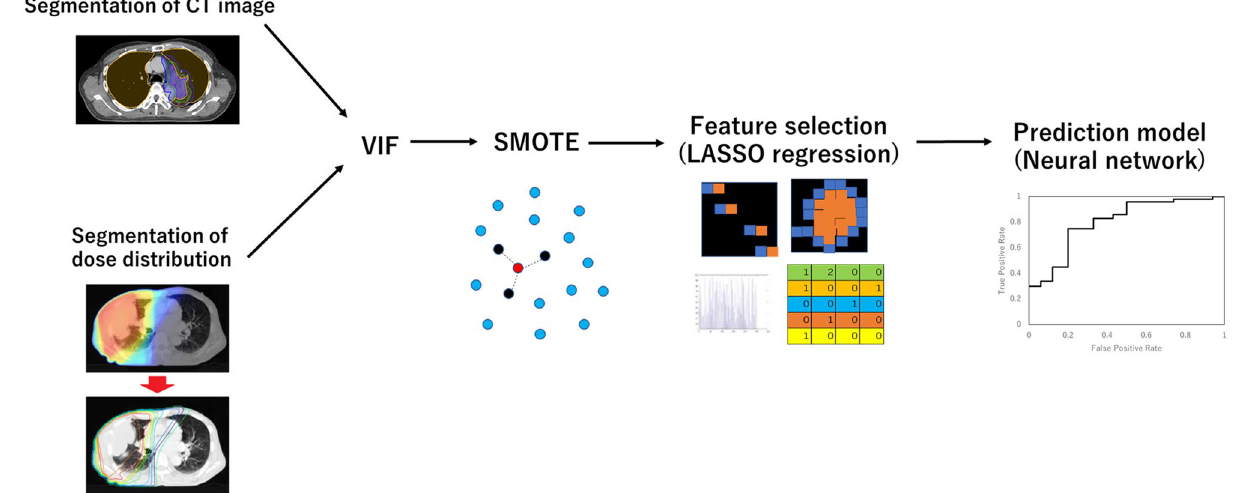
Figure 1. Process of the radiomics analysis and creation of the prediction